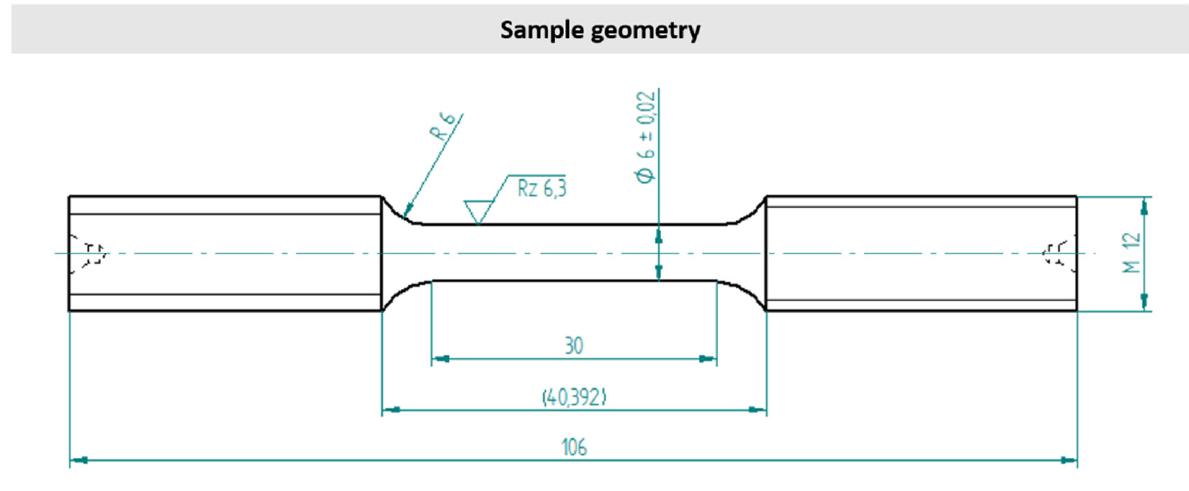
Figure 4. Sample geometry for in situ diffraction analysis during uniaxial tensile loading.